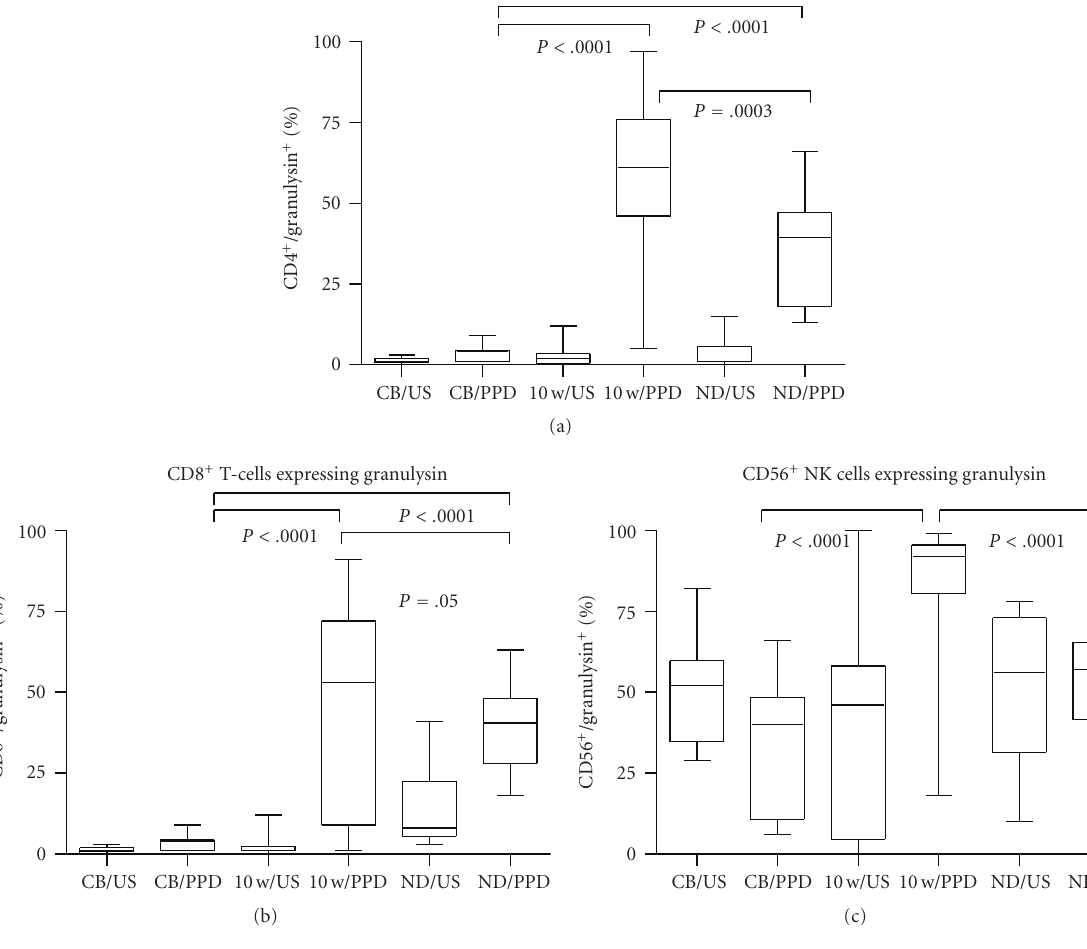
Figure 2: Granulysin expression in CD4 + (a) and CD8 + (b) T-cells and CD56 + (c) NK cells in unstimulated (US) and PPD-stimulated mononuclear cells isolated from cord blood (CB, n = 10) or peripheral blood from BCG-vaccinated infants (10w, n = 45) or healthy PPD + adult volunteers (ND, n = 10). Significance is shown as PPD stimulation in CB compared to 10-week-old infants and healthy adult controls, and 10-week-old infants compared to healthy adult controls. The box extends from the 25th to 75th percentile, the line represents the median, and the whiskers represent the maximum and minimum